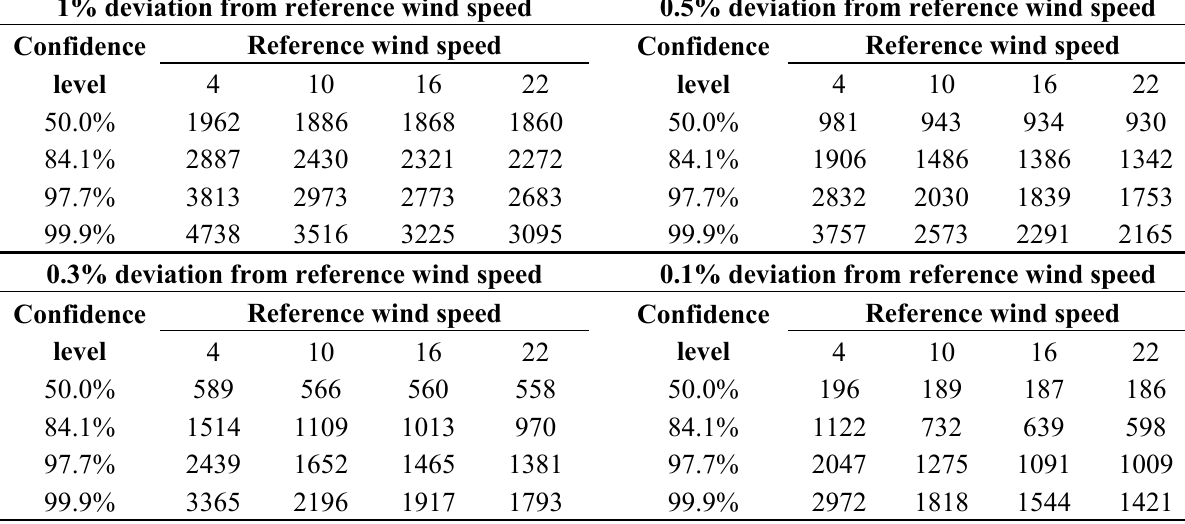
Table 2. Recalibration schedule (days after the initial calibration) of the IDR/UPM Institute Cl-100075 anemometer for reference wind speeds 4, 10, 16 and 22 m·s − 1 as a function of the deviation from the reference wind speeds, and the confidence